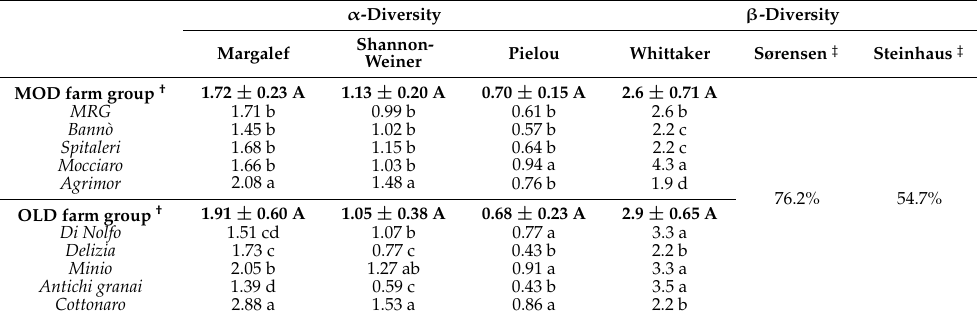
Table 2. α - and β -diversity indices of weed species in the total seedbank (0–15 cm) across the 10 farms under study.